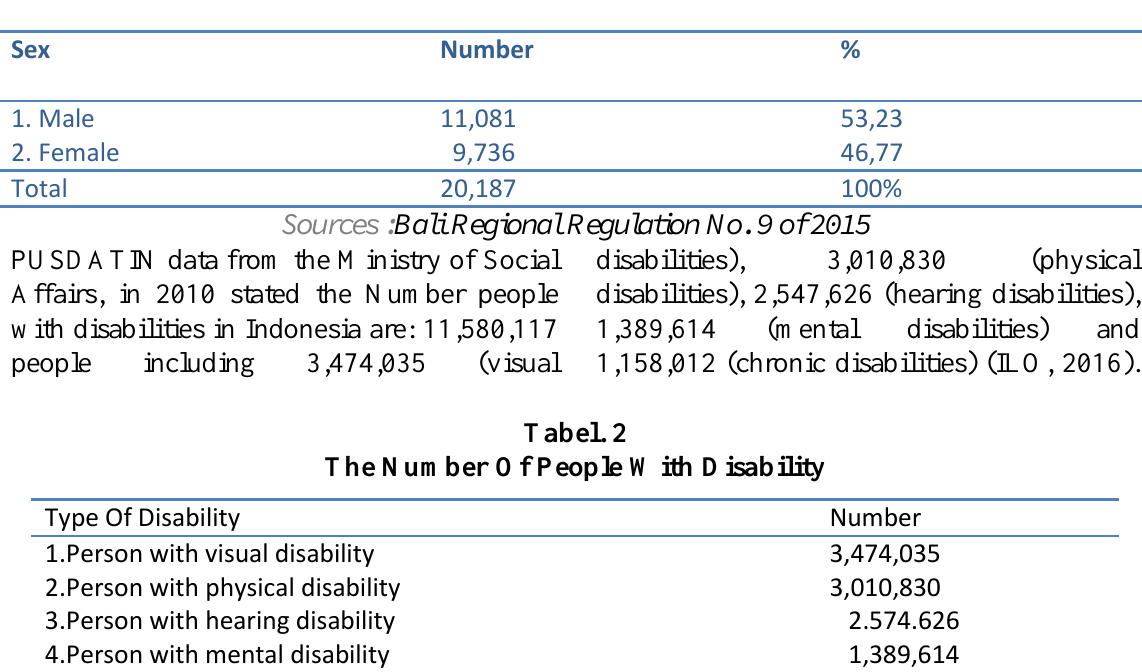
Table 2.The Number of Person with DisabilityBased on SexIn